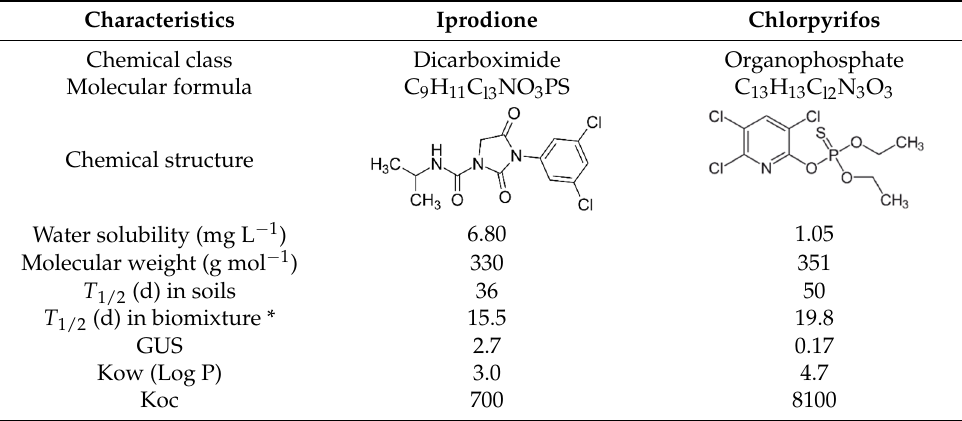
Table 1. Chemical properties of pesticides used in this study. Characteristics